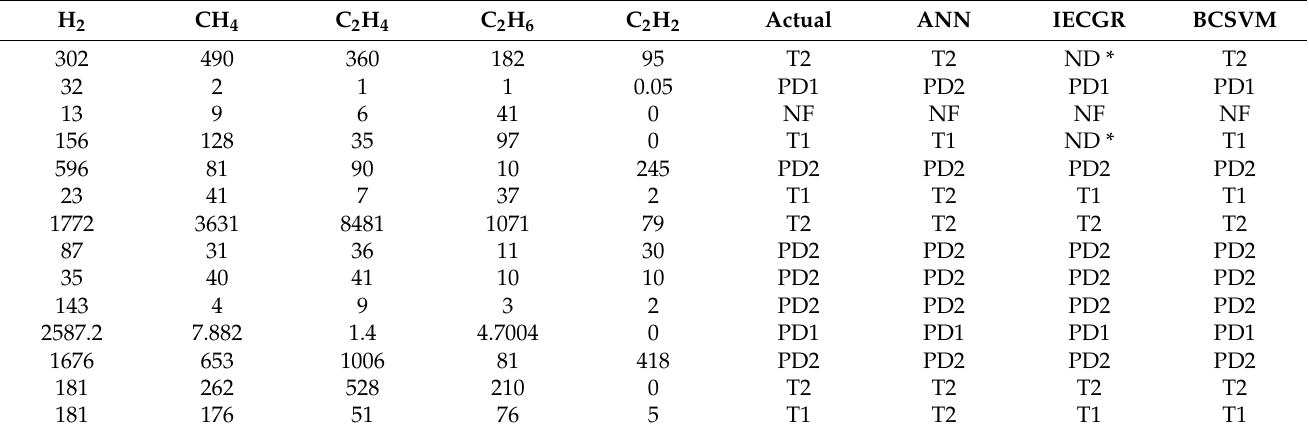
Table 8. DGA fault classification case